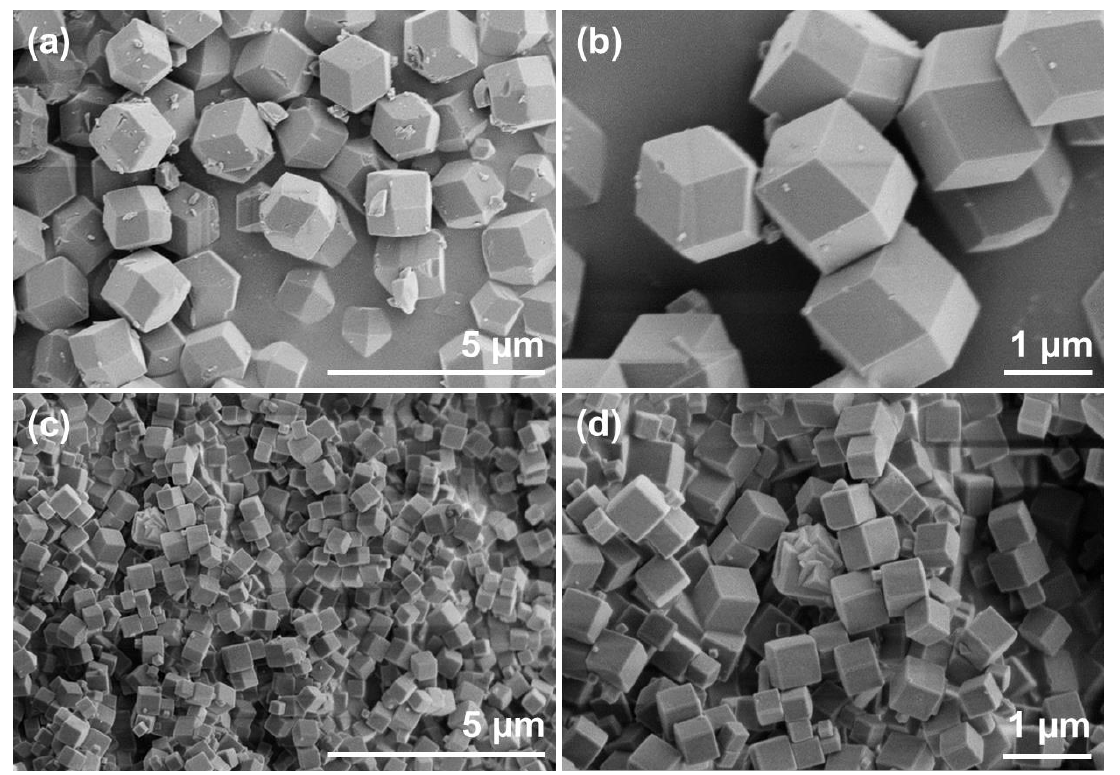
Figure 4. SEM images of ZIF-8 ( a , b ) and ZIF-8@RB ( c , d ). Nitrogen adsorption/desorption porosimetry was employed to characterise both ZIF- 8 and ZIF-8 rhodamine B materials and to observe any porosity changes presented by the